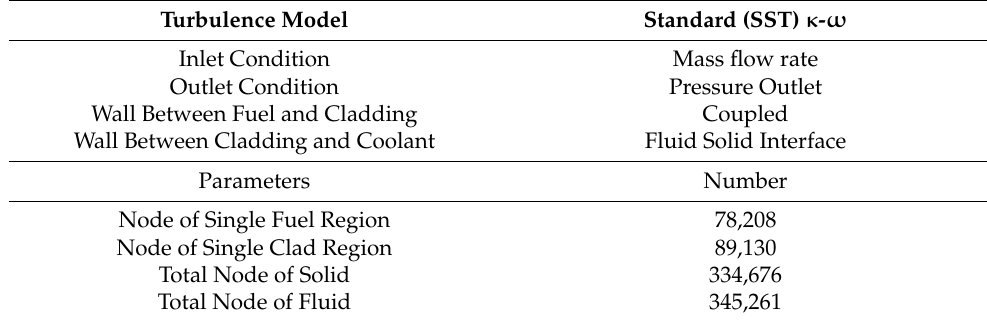
Table 3. Boundary conditions, solving algorithm, and mesh parameters.